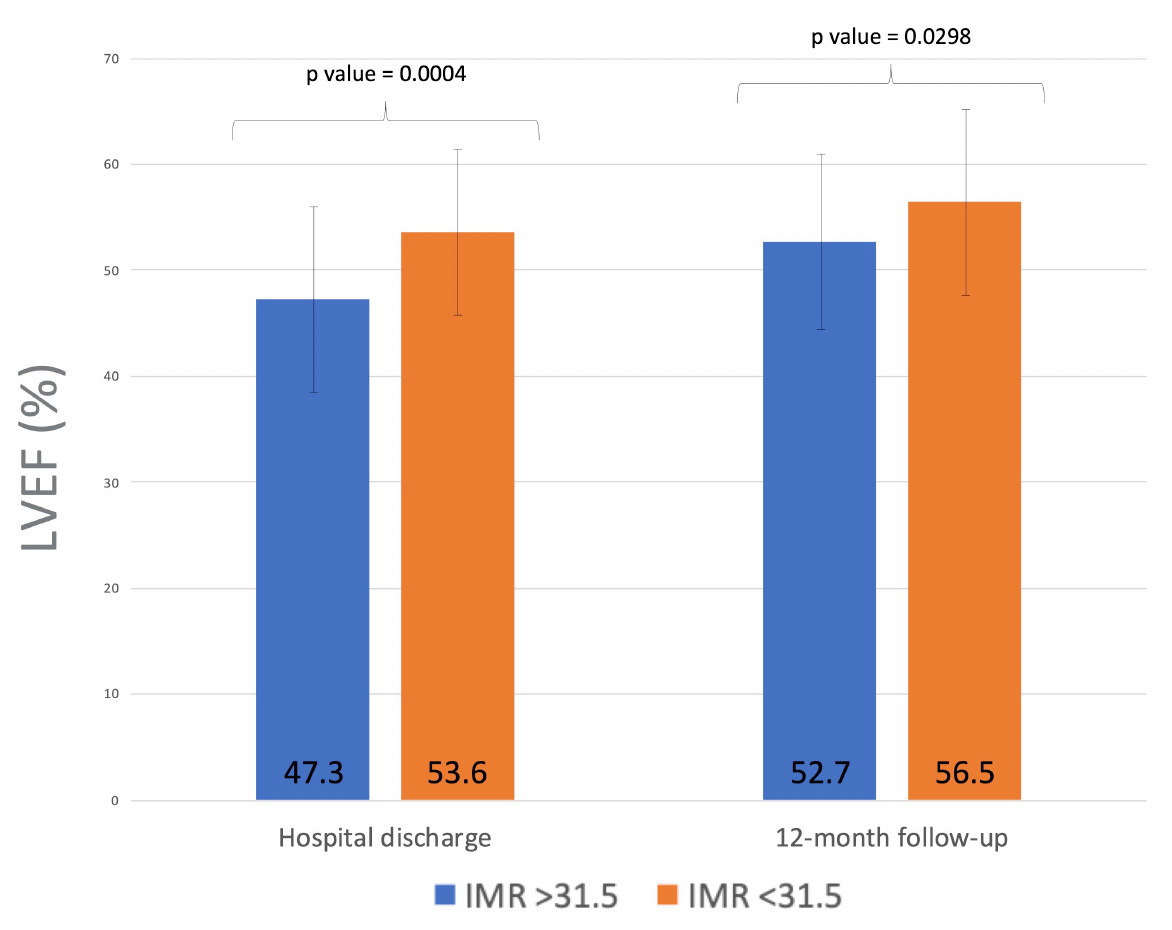
FIGURE3 Index of microvascular resistance (IMR) after PPCI of the left anterior descending artery and left ventricular EF at hospital discharge and 12 months follow-up. Higher IMR measurements after PPCI predicted lack of improvement of LV function at follow-up in patients with anterior myocardial infarction. IMR, index of microvascular resistance; PPCI, primary percutaneous coronary intervention; EF, ejection fraction; LV, left